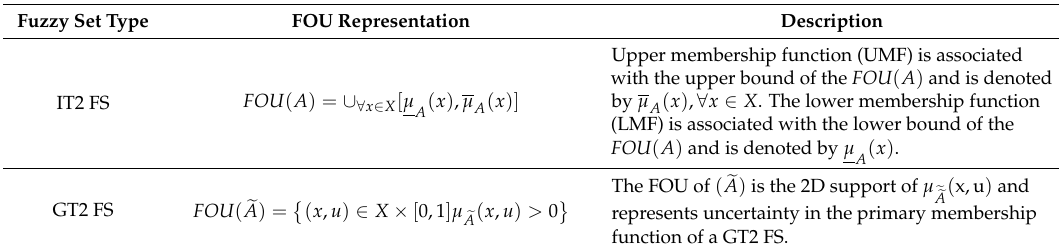
Table 2. Footprint of uncertainty (FOU) IT2 and GT2 FS